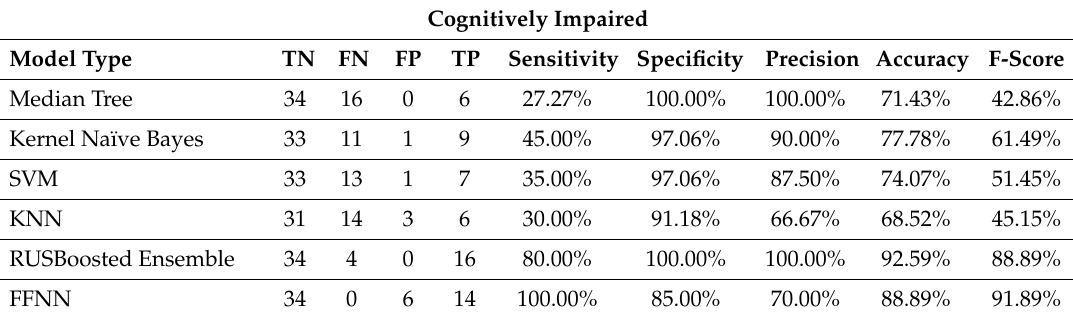
Table 5. Testing the